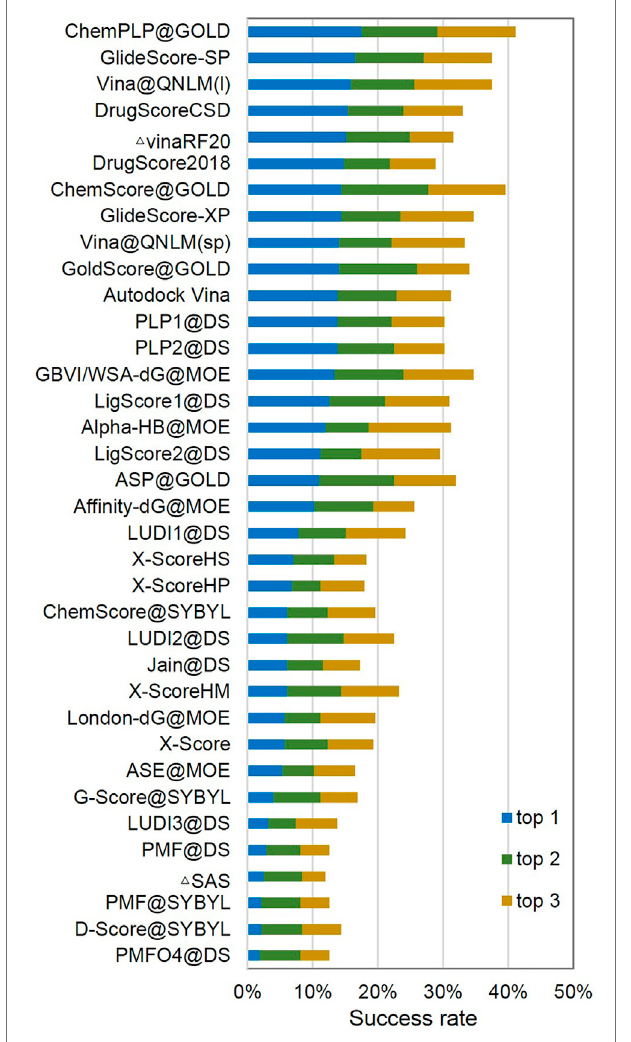
FIGURE11| Screeningpoweroftop1(1%),top2(5%),andtop3(10%) reverse screening success rates of Vina@QNLM in single-point and local modes (blue, green, and orange bars), compared tothe methods evaluated in CASF-2016 and recalculated.